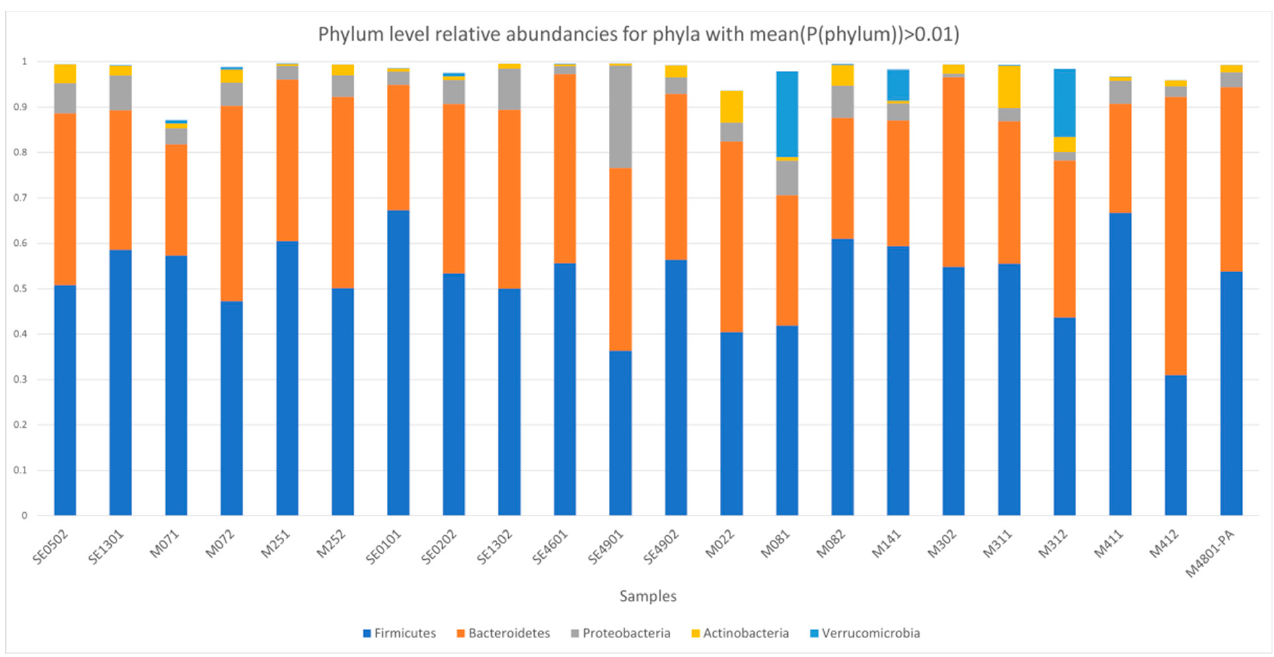
Figure 13. The relative abundances of bacteria at the phylum level between the two groups. The first 6 columns are the subjects of the OSA − atherosclerosis group, and the next 16 columns are the subjects of the OSA + atherosclerosis group.